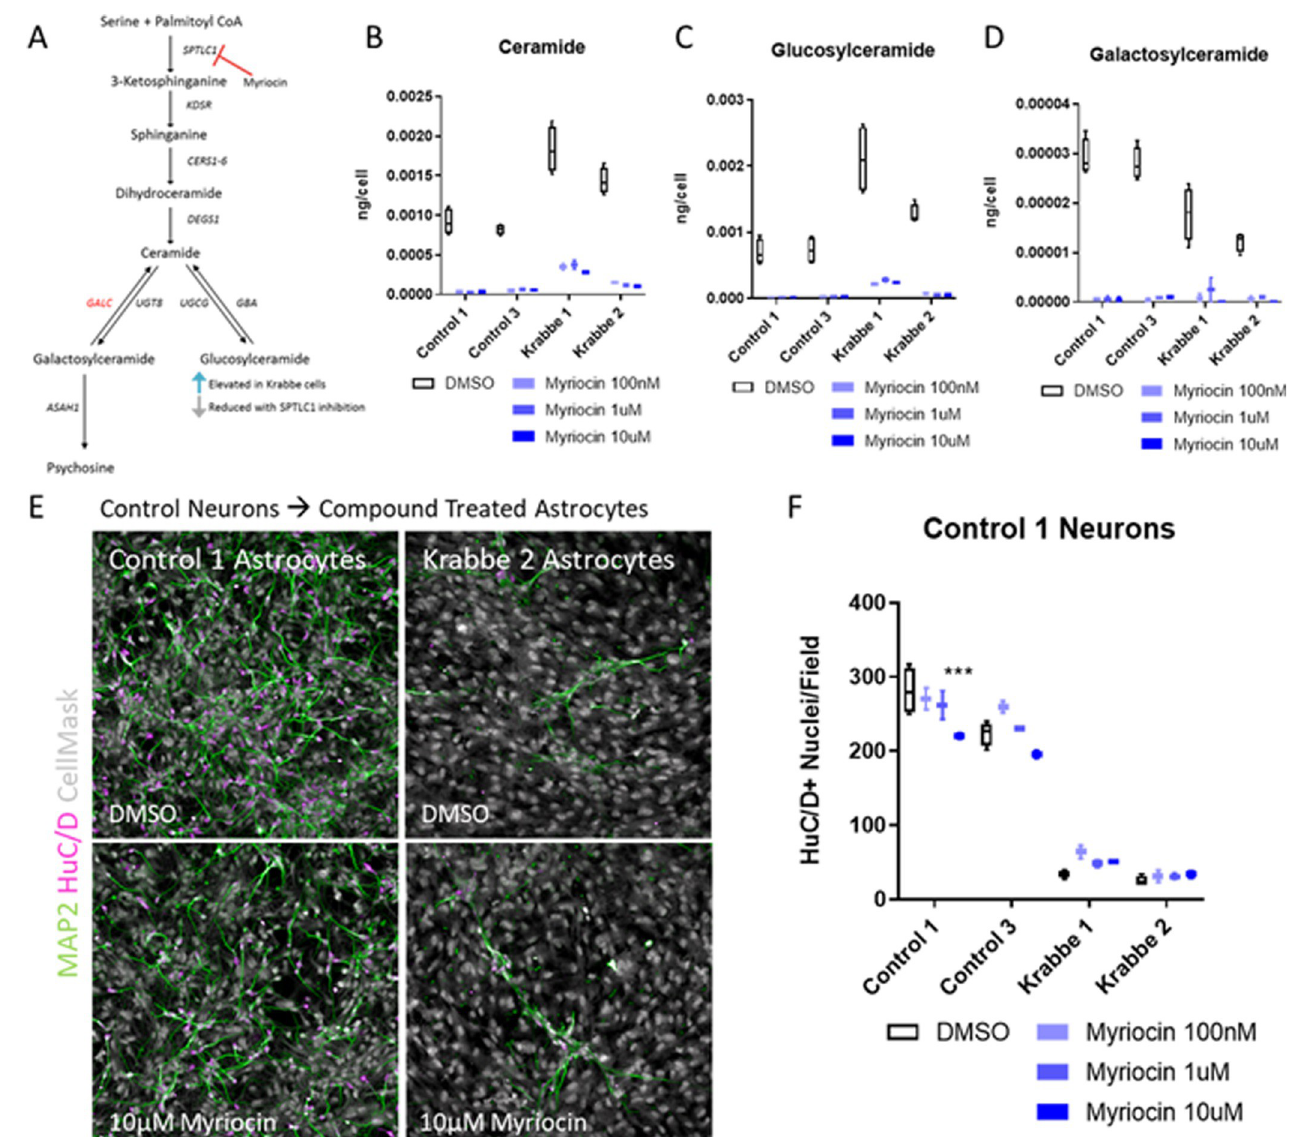
Fig 5. Inhibiting synthesis of ceramide in Krabbe astrocytes fails to facilitate neuronal survival. Cryopreserved astrocytes from healthy control and Krabbe donors were seeded into microwell plates, cultured for 24 hours, and then treated with compound for 6 days prior to analysis. (A) A schematic depicting the biosynthesis of ceramide-derived glycosphingolipids, and the rationale for reducing glucosylceramide via inhibition of SPTLC1 with myriocin. (B-D) Target engagement of myriocin was verified by GC-MS-MS. Myriocin reduced ceramide and its derivatives glucosylceramide and galactosylceramide in control and Krabbe astrocytes. (E, F) Representative images of neuron-astrocyte co-cultures and quantification of the number of HuC/D+ nuclei. No beneficial effect of myriocin was observed when control neurons were co-cultured with Krabbe astrocytes for 72 hours. Data is shown as a box and whisker plot with median represented and errors bars indicating min/max values. ��� p <